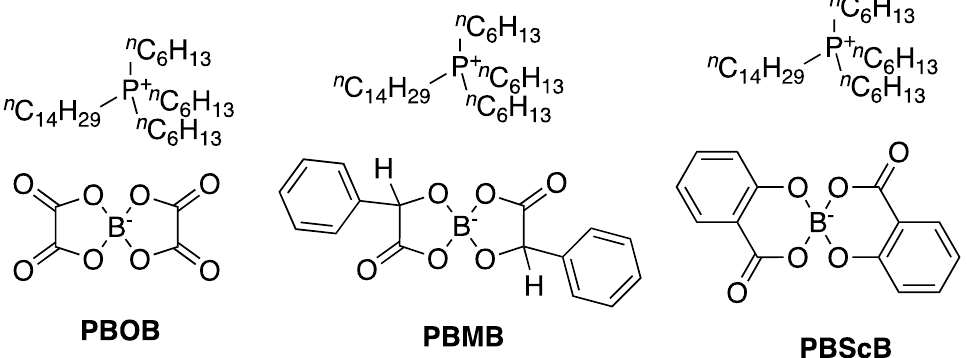
Figure 1. The ionic liquids used in this work: trihexyl(tetradecyl)phosphonium bis (oxalato)borate (PBOB), trihexyl(tetradecyl)phosphonium bis (mandelato)borate (PBMB), and trihexyl(tetradecyl)phosphonium bis (salicylato)borate